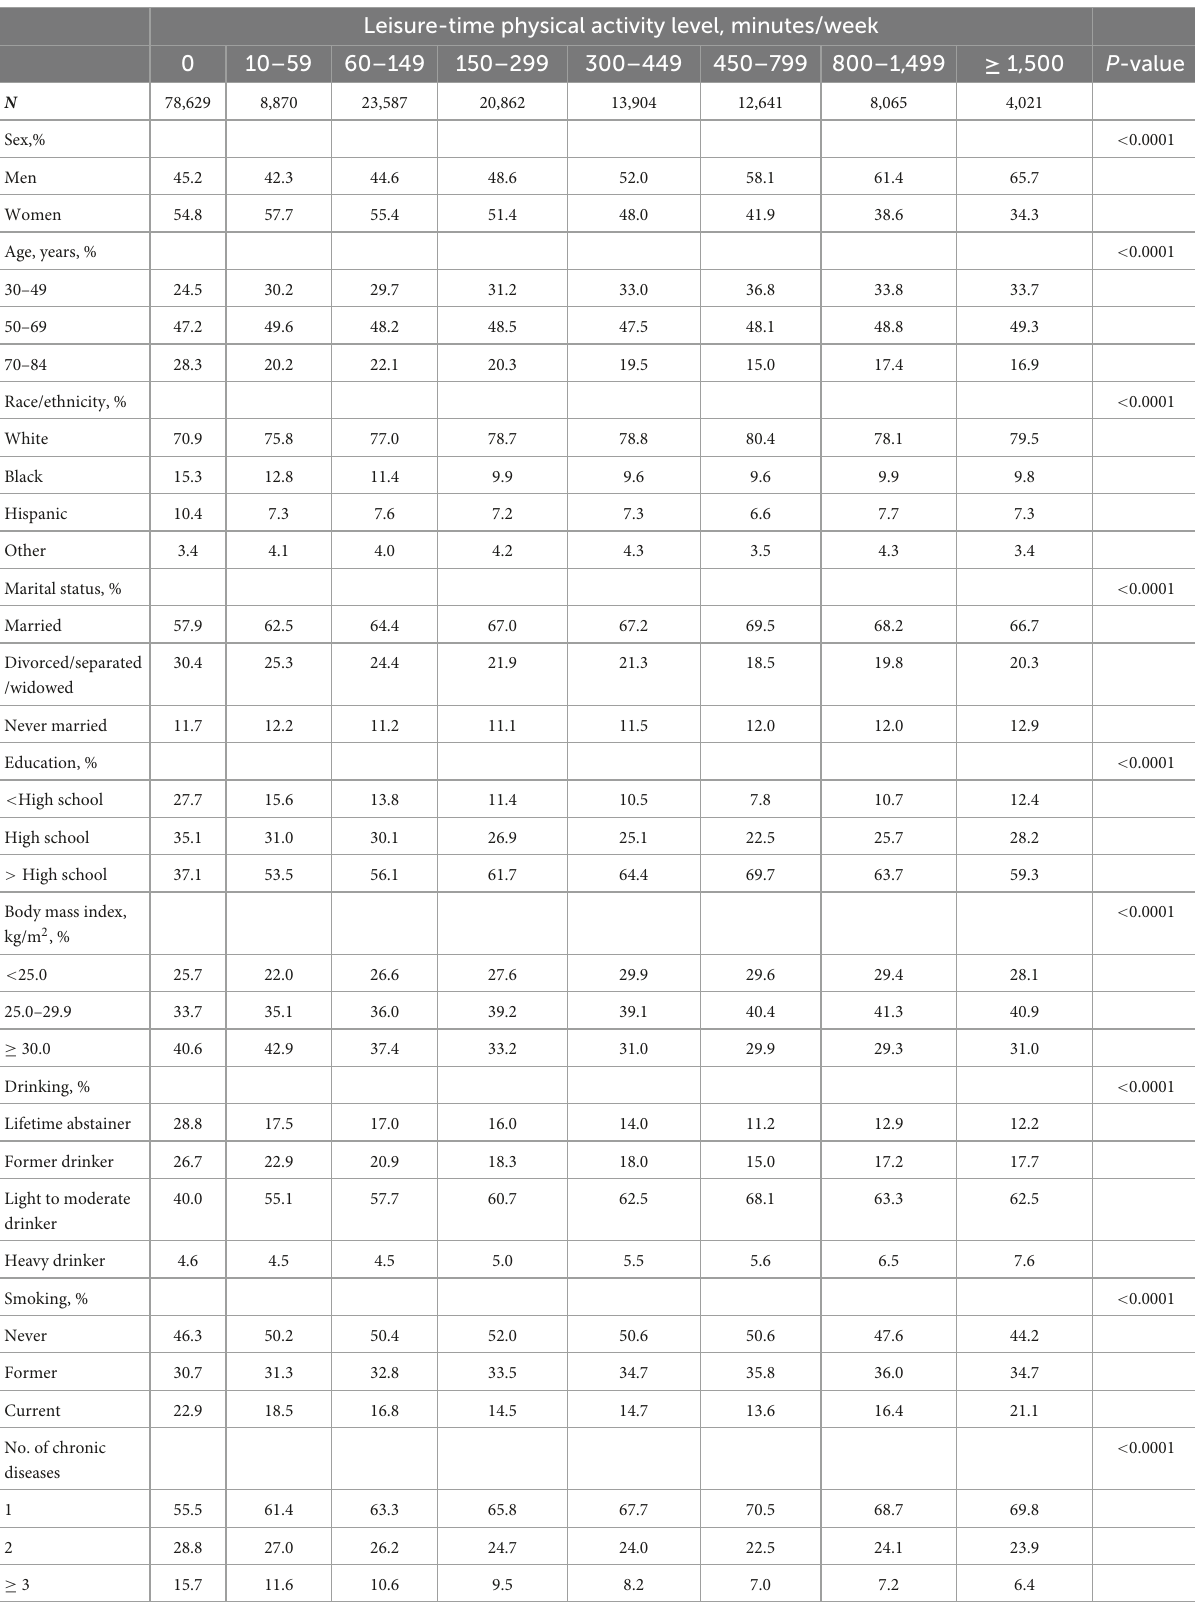
TABLE 1 Baseline characteristics according to total leisure-time physical activity level, NHIS